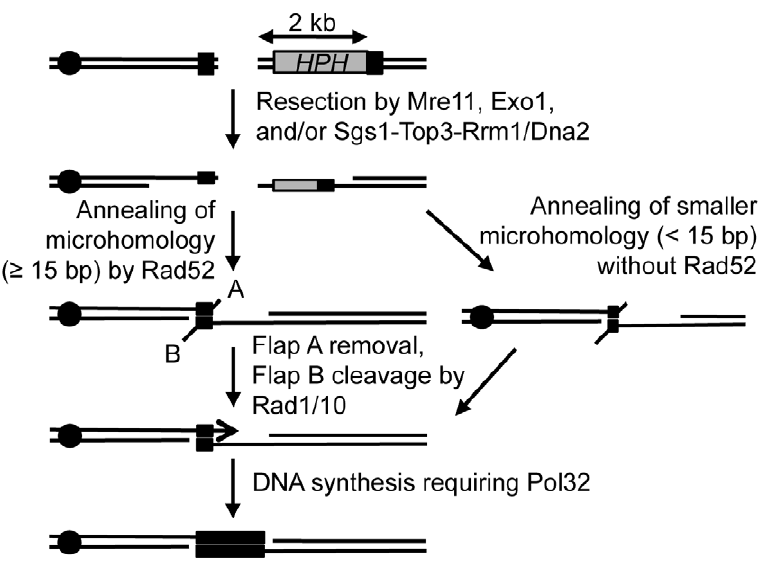
Figure 6. Proposed mechanism for repair of a DSB using microhomology. After a break, ends are resected to single-stranded DNA, and microhomology flanking the break (shown in black boxes) are brought together and annealed. Rad52 facilitates repair using microhomology that is 15 bp or longer, and microhomology less than 15 bp is inhibited by Rad52. A 2 bp 3 9 flap (A) is removed, likely through the proof-reading activity of Polymerase d , and a 2 kb 3 9 flap (B) is removed by the Rad1/Rad10 heterodimer endonuclease. Pol32 stabilizes the annealed microhomology and the break is healed, deleting the intervening DNA and one of the microhomology sequences, similar to SSA. The location of the centromere (black circle) is shown.